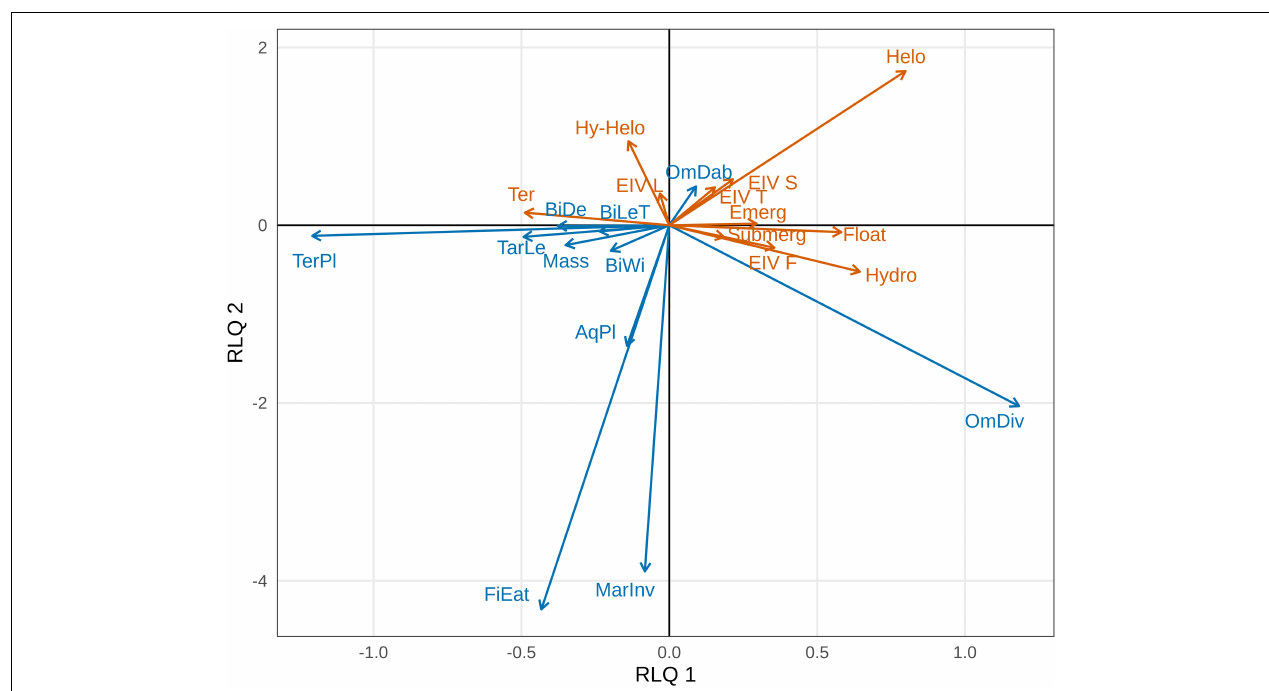
FIGURE 1 | Waterfowl (in blue) and plant traits (in orange) projected onto the first two axes of the RLQ analysis. We only present traits with correlations > 0.5 with at least one axis. Traits showing positive (or negative) associations to the same axis are interpreted as being associated. Values of the correlations of each trait to each axis can be found in Supplementary Material 6 , and their significance according to the fourth-corner test is given in Figure 3 . BiLeT, Bill length; BiDe, Bill depth; BiWi, Bill width; TarLe, Tarsus length; OmDab, Omnivorous dabbling ducks; OmDiv, Omnivorous diving ducks; TerPl, Terrestrial plant-eaters; AqPl, Aquatic plant-eaters; MarInv, Marine invertebrate-eating diving ducks; FiEat, Fish-eating diving ducks; EIV, Ellenberg Indicator Value for soil moisture (F), salinity (S), temperature (T), and light exposure (L); Helo, Helophyte; Hy-helo, Hydato-helophyte; Hydro, Hydrophyte; Ter, Terrestrial; Submerg, Submerged; Float, Floating leaved; Emerg,